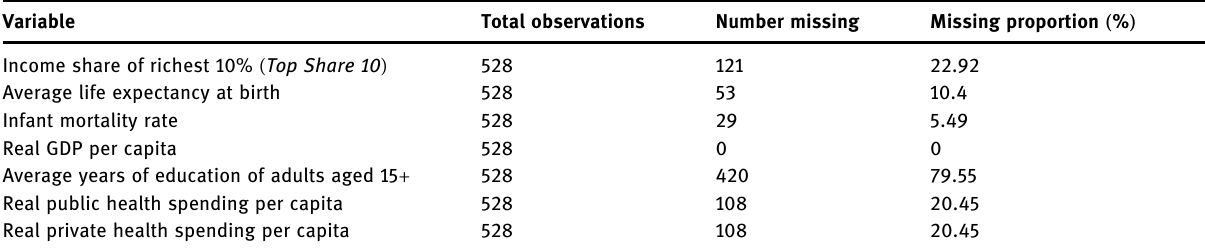
Table 3: Missing Data in Reconstructed Leigh and Jencks ’ ( 2007 ) Dataset